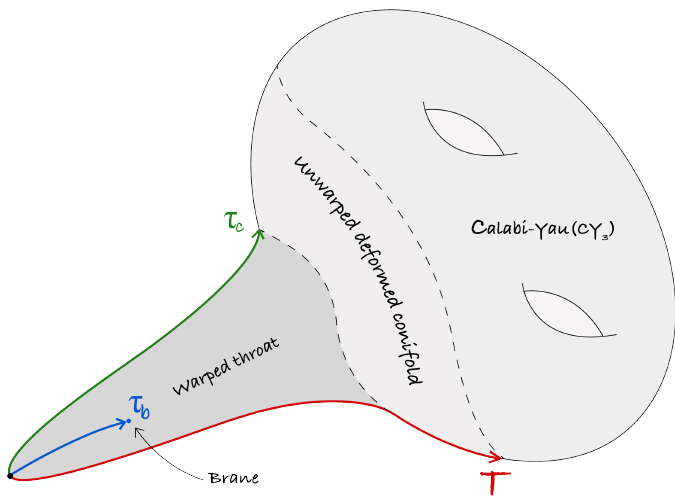
Figure 2 . The internal space consists of a 6d compact manifold with a warped region described by the Klebanov-Strassler solution (i.e. a warped deformed conifold). We split the bulk into two different pieces: one piece is a generic CY 3 and the other takes the metric of an unwarped deformed conifold and serves as a transition between the warped throat and the CY 3 (with τ c < τ < T , where τ is the radial coordinate in the deformed conifold metric